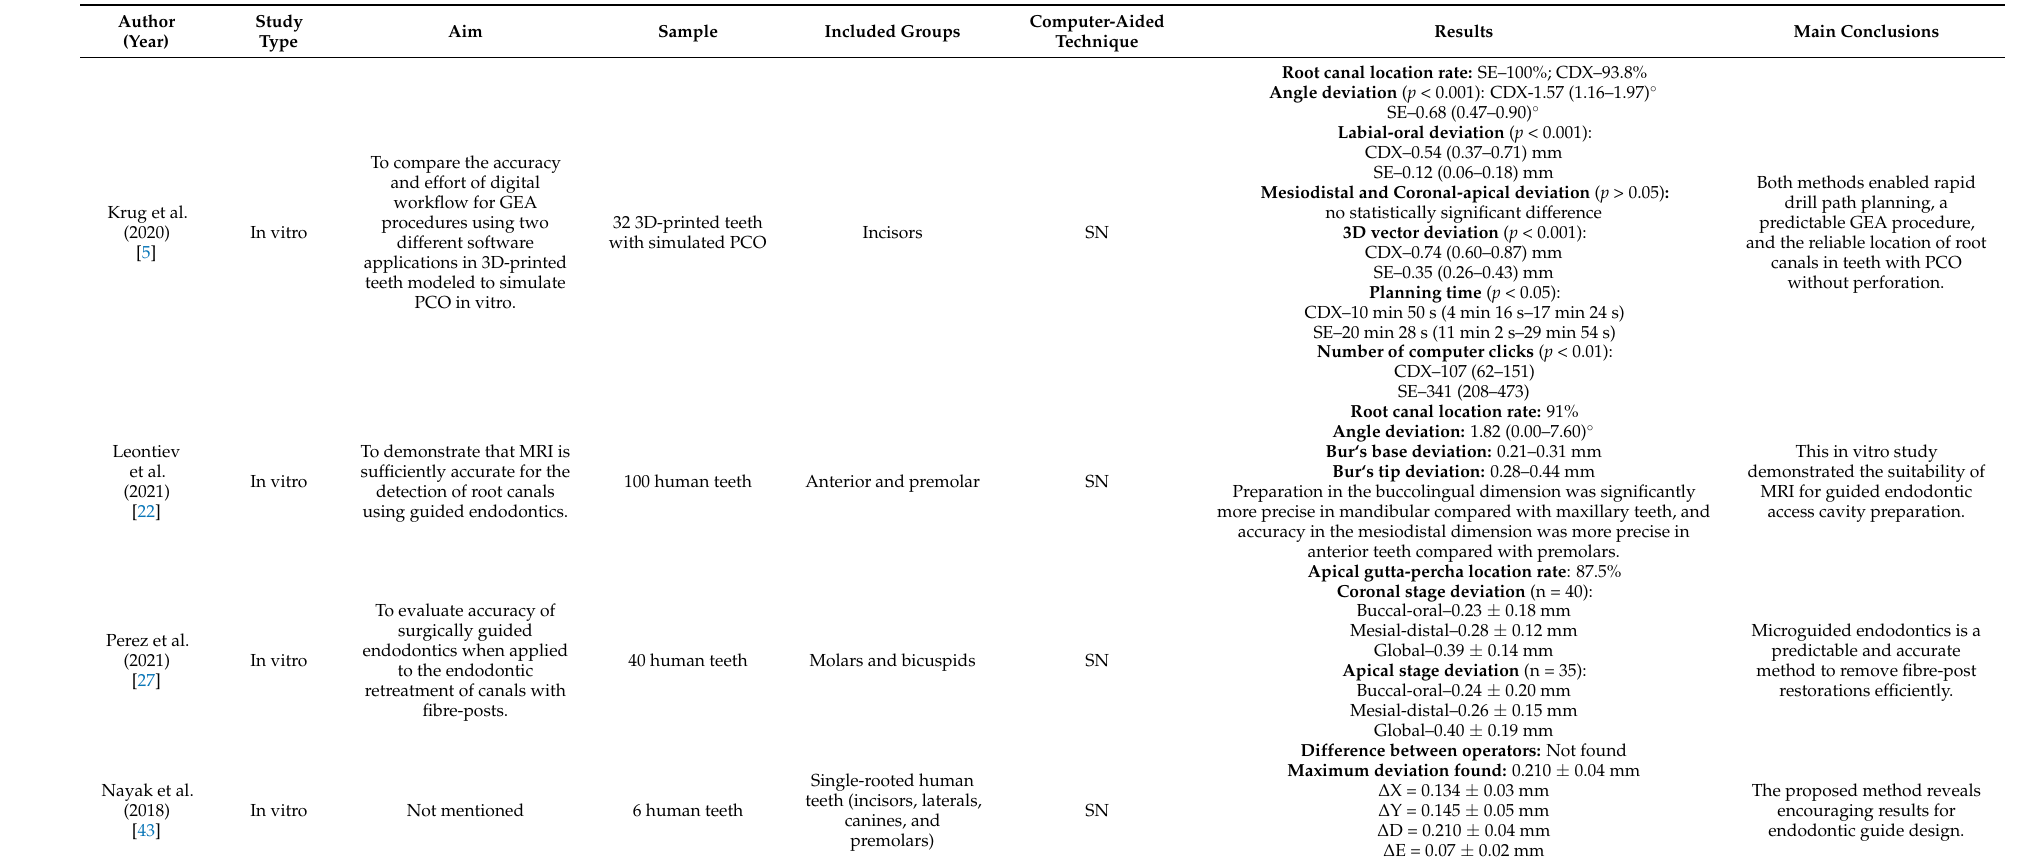
Table 1. Included original research